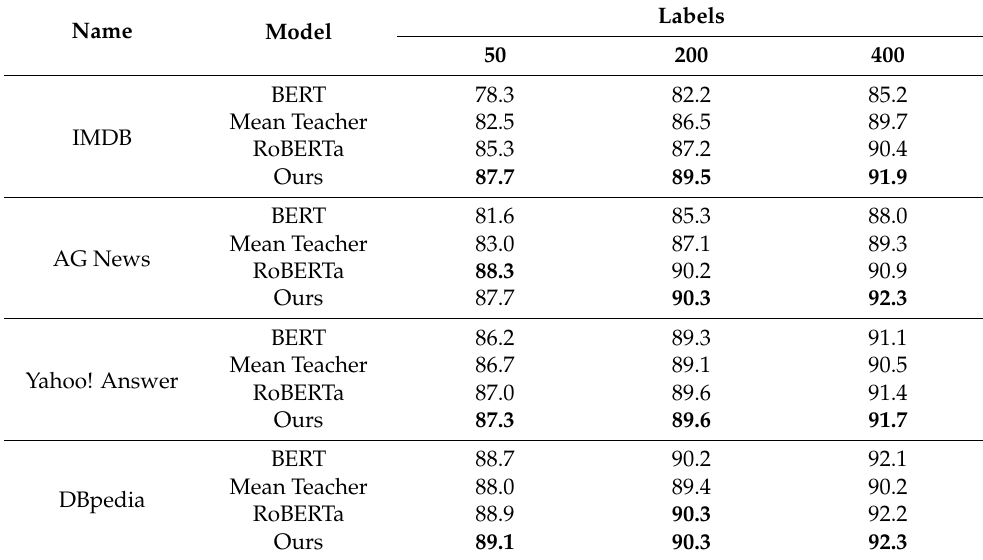
Table 4. Comparison of the accuracy of each algorithm (%). Bold indicates that this data represents the best performance in this comparison.